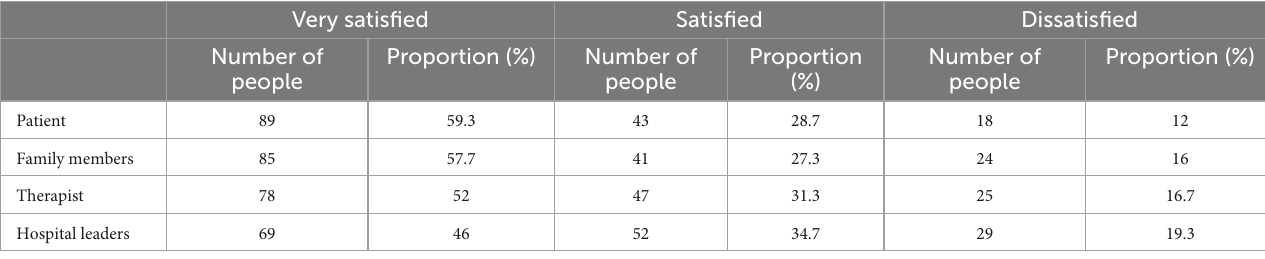
TABLE 1 Satisfaction of four categories of personnel with new music